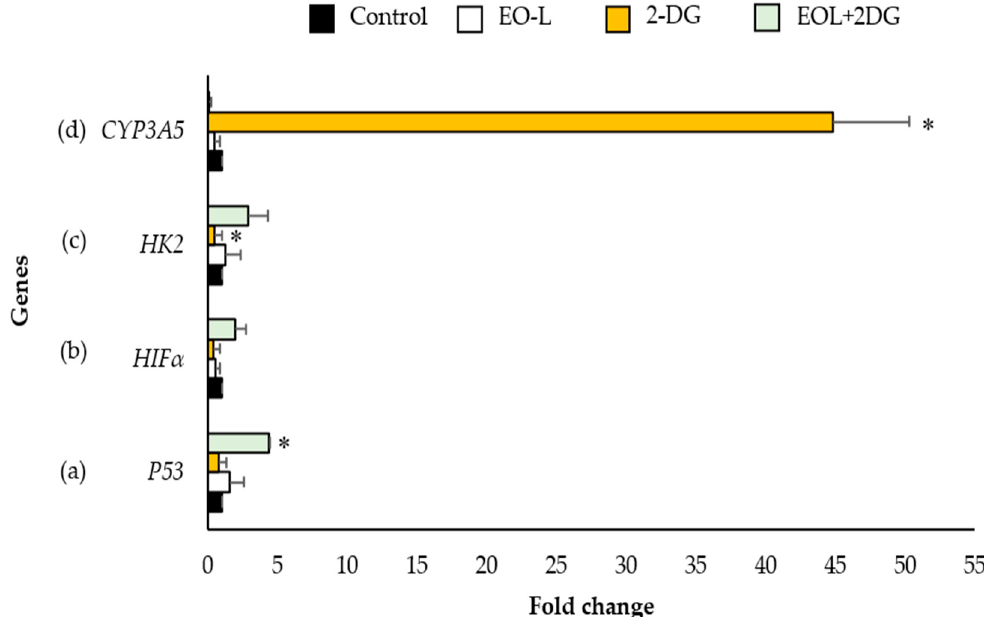
Figure 13. mRNA expression of ( a ) P53, ( b ) HIF α , ( c ) HK2 and ( d ) CYP3A5 in PANC-1 cells treated with EO-L, 2-DG and EOL+2DG. The fold change was calculated as a relative change in each mRNA level in comparison with the control expression level (expression of equals to 1.0). The mean values ± S.D. were obtained from three independent experiments that ran in triplicate. Statistical significance was assigned to a fold change based on a Student’s t -test between control (untreated cells) and treatment samples expression values, with the * symbol showing a significant difference ( p < 0.05) in comparison to control